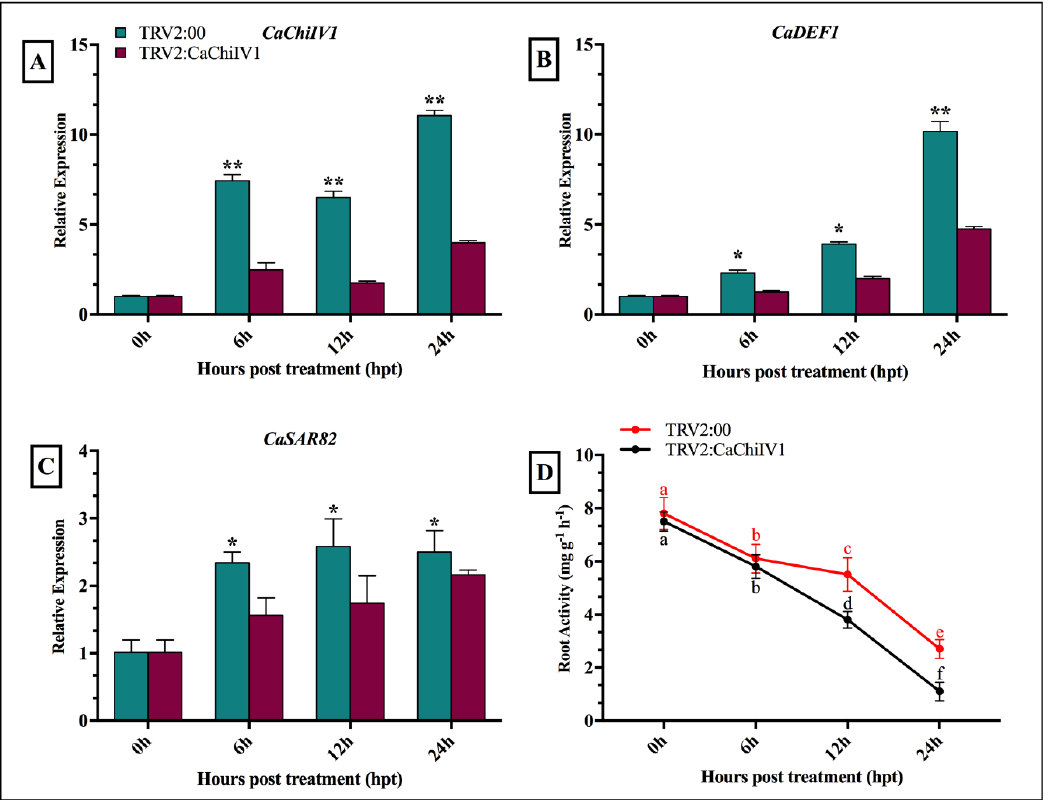
Figure 11. The CaChiIV1 -silenced pepper plants exhibit reduce resistance to NaCl stress: ( A ) The transcript level of CaChiIV1 ; ( B ) transcript level of CaDEF1 ; ( C ) transcript level of CaSAR82 ; and ( D ) root activity of the control and CaChiIV1 -silenced plants. Values are the means ± SD from three separate experiments. Small letters (a–f) and asterisk (*significant and **highly significant) denote significant variation ( p <